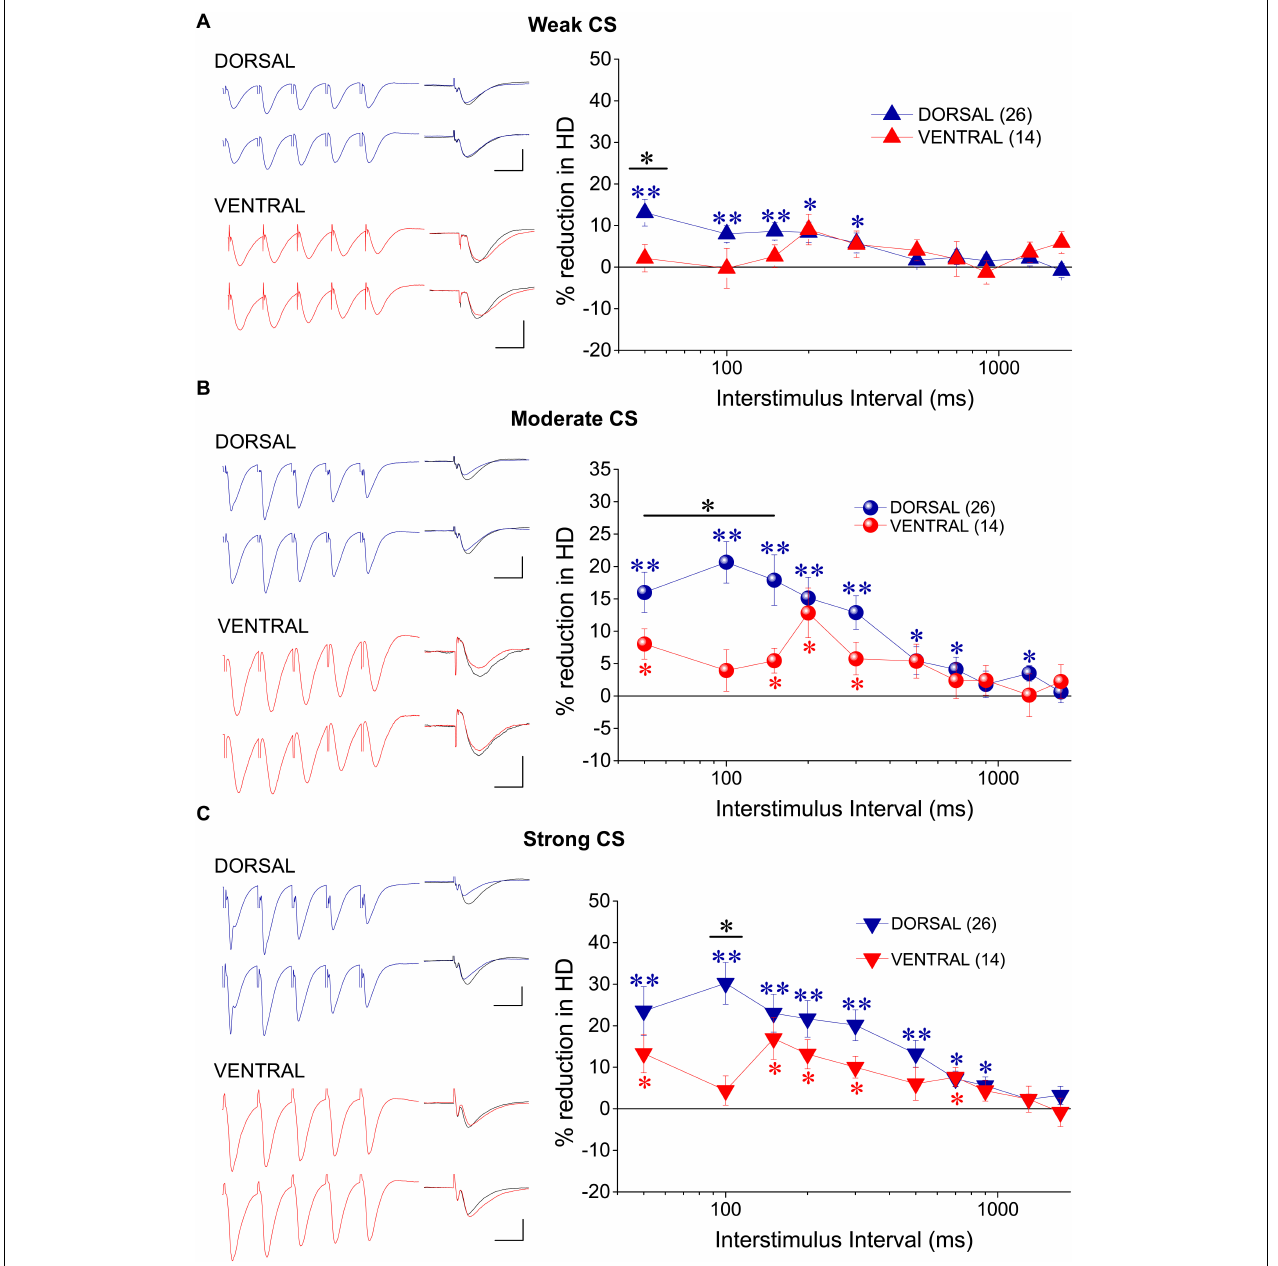
FIGURE 5 | tHSD involves activation of adenosine A 1 Rs more in dorsal than in ventral hippocampus. Examples of fEPSP recordings (at an inter-stimulus interval of 200 ms) and collective results are shown in the left and the right panel, respectively. The reducing effects of the antagonist of A 1 Rs DPCPX (150 nM) on tHSD are presented as a percent change of tHSD between normal and drug conditions. The drug effects are shown for weak (A) , moderate (B) , and strong intensity of CS (C) . In example traces, a 150 ms-long interval between conditioning and test response is omitted for clarity reasons. Traces in black denote control responses at the conditioned path. Calibration bars: 1 mV, 10 ms. Artifacts are truncated. Numbers into parenthesis indicate the number of slices used. Asterisks above (dorsal hippocampus) or below symbols (ventral hippocampus) denote statistically significant differences between normal and drug conditions, at * p < 0.05 and ** p < 0.001 (paired t -test). Horizontal bars denote statistically significant differences between the dorsal and the ventral hippocampus, at * p < 0.05 and ** p < 0.001 (independent t -test). For additional statistical tests (ANOVA, MANOVA) see main